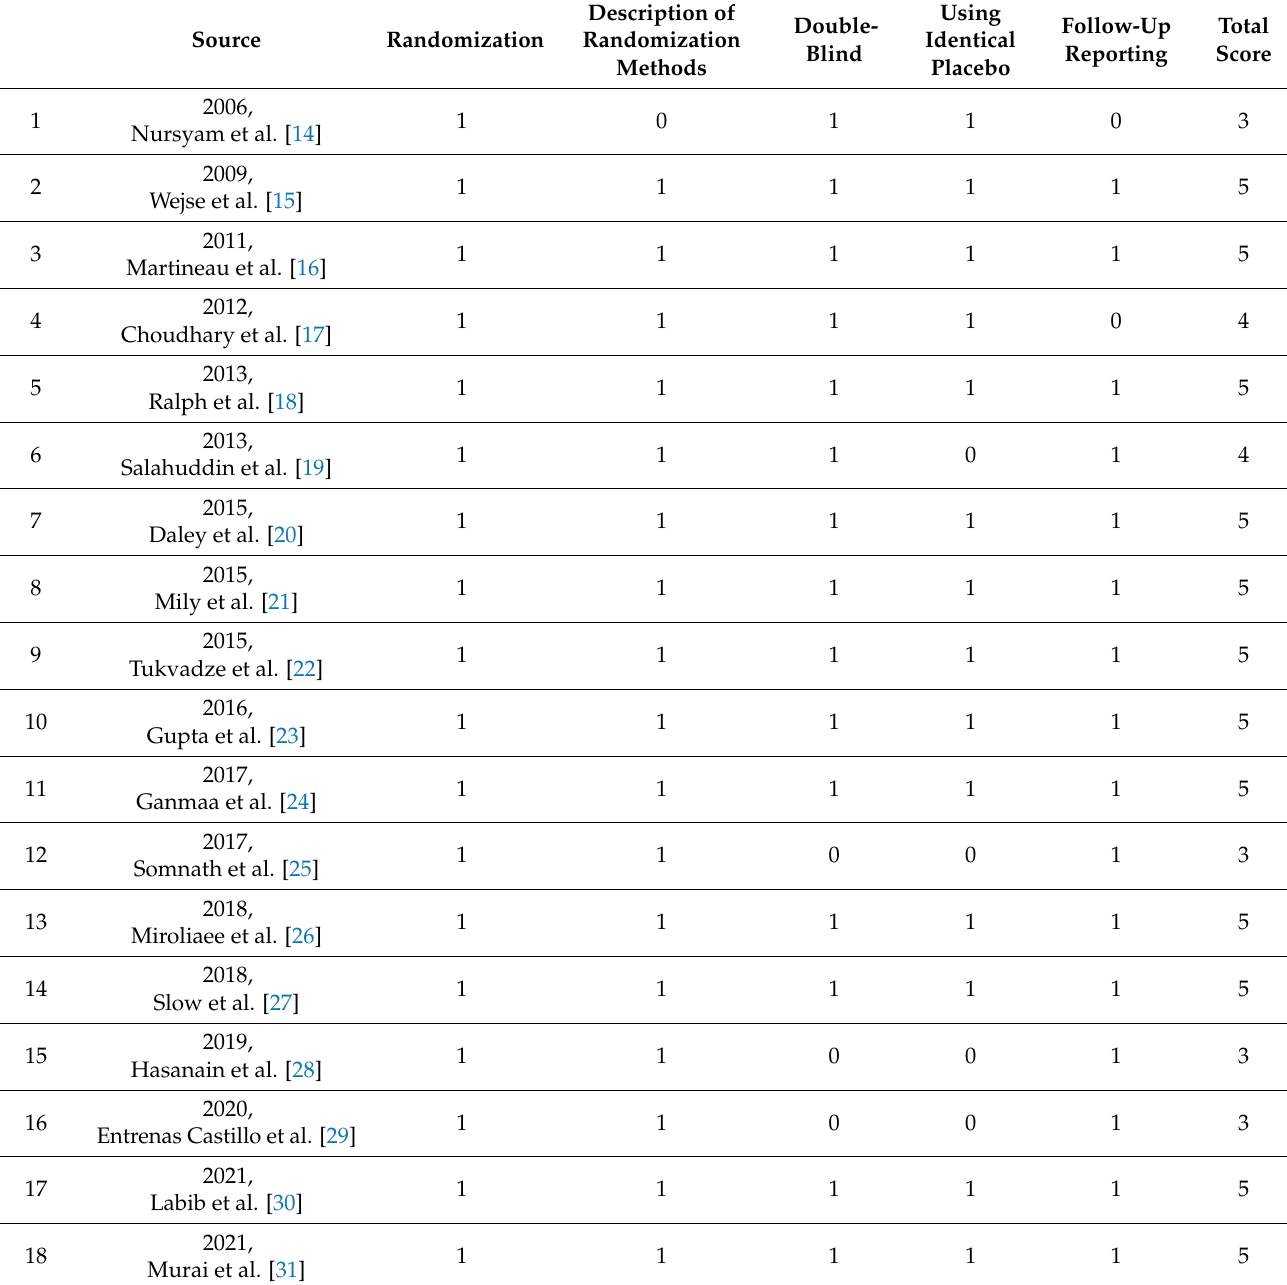
Table 3. Methodological quality of trials based on the Jadad Scale ( n =